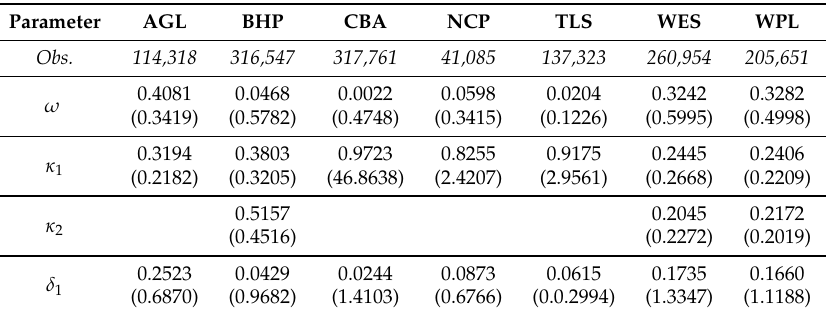
Table 4. Coefficient estimates of GARCH parameters of the conditional variance of the residuals for all stocks. ω , constant; κ , GARCH parameters; δ , ARCH parameters